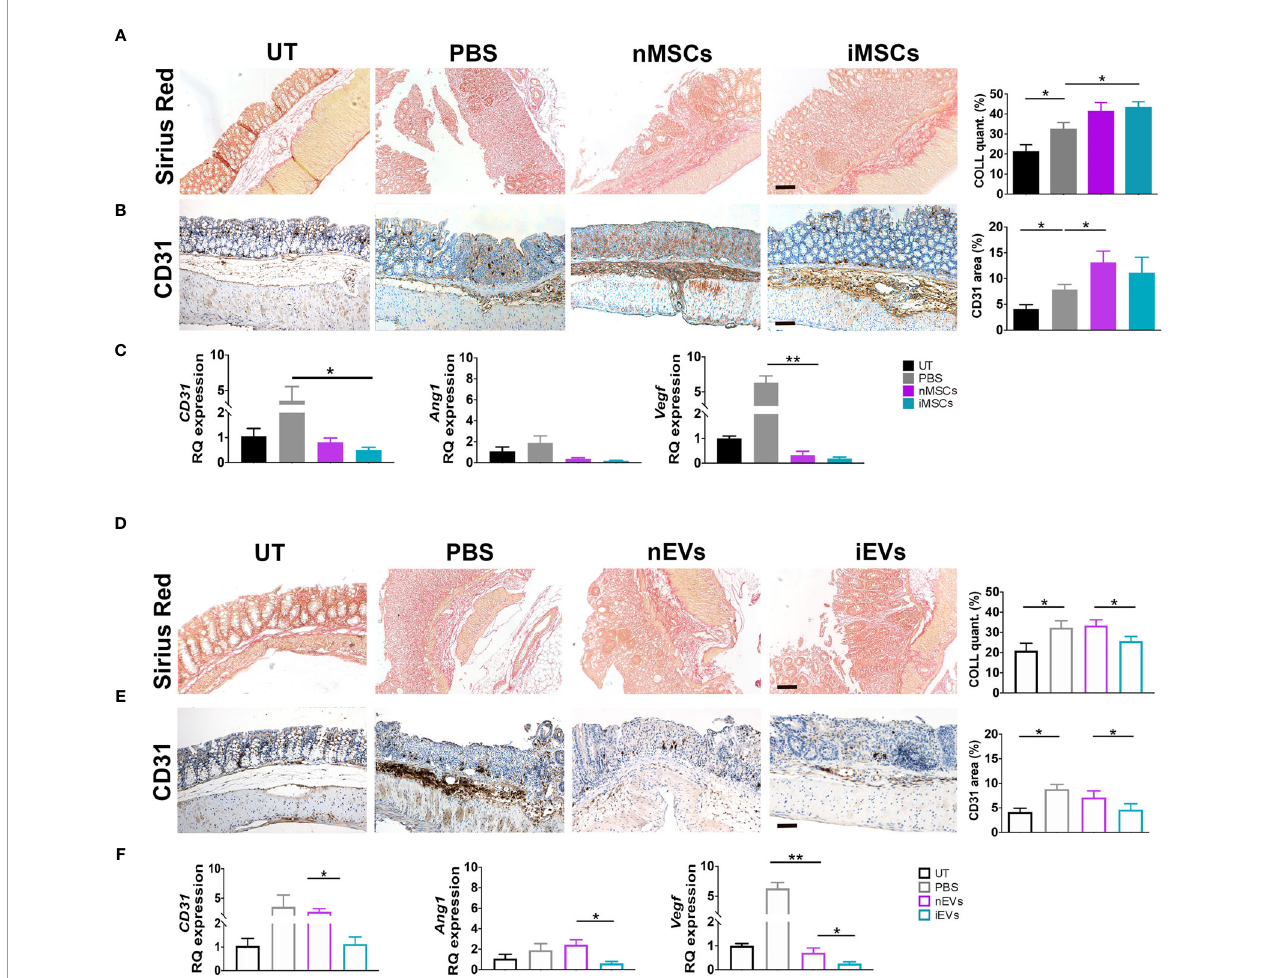
FIGURE 6 | MSCs and iEVs exert opposite effect on fi brogenesis and angiogenesis in mice with colitis. (A) Collagen deposition in colon mucosa: Sirius red (left), quanti fi cation (right). (B) Quantitative CD31 staining as a measure of angiogenesis in colon mucosa: immunocytochemistry (left), quanti fi cation (right). (C) qRT-PCR of CD31, Angiopoietin, Vegf genes. All the genes were down regulated in nMSCs and iMSCs injected mice. (D) Collagen deposition in colon mucosa: Sirius red (left), quanti fi cation (right). (E) Quantitative CD31 staining as a measure of angiogenesis in colon mucosa: immunocytochemistry (left), quanti fi cation (right). (F) qRT-PCR of CD31, Angiopoietin, Vegf genes. With the exception of CD31 in nEVs, Angiopoietin and Vegf were down regulated in nEVs and iEVs injected mice. Scale bar: 50 m m. Results are mean ± standard error (n = 5). *P < 0.05, **P <